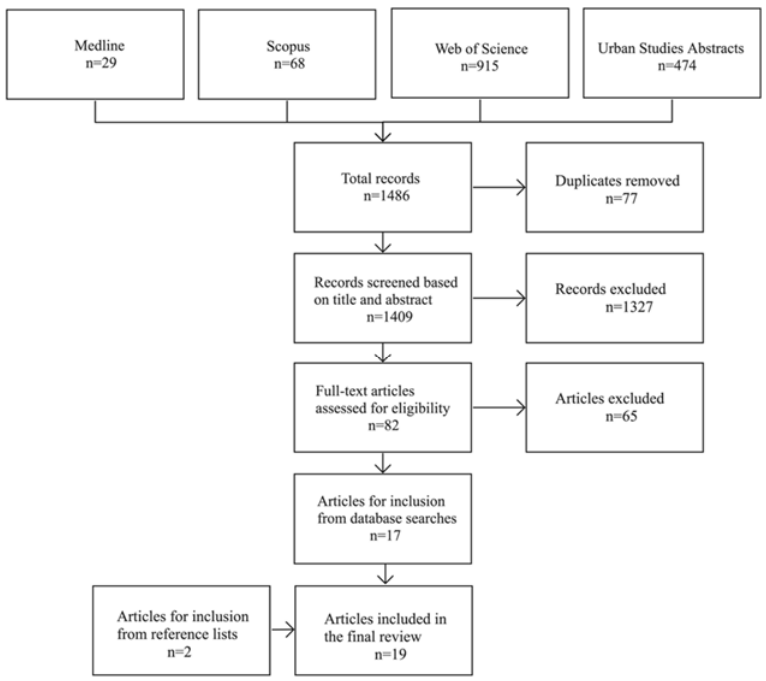
Figure 1. PRISMA flow diagram depicting the article selection process.